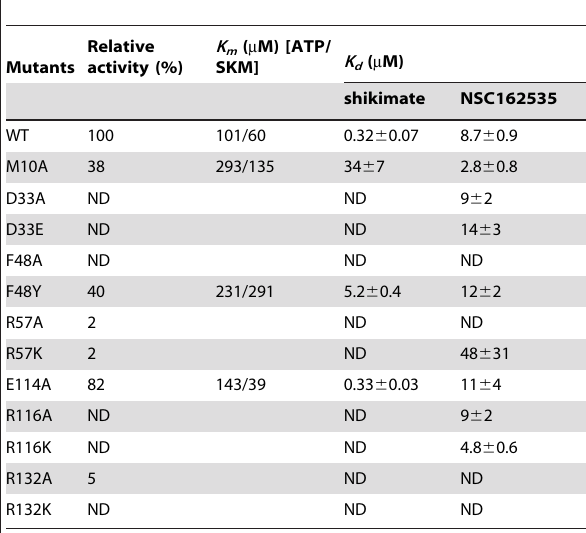
Table 1. Comparison of the relative activities and K d values of wild-type and mutant